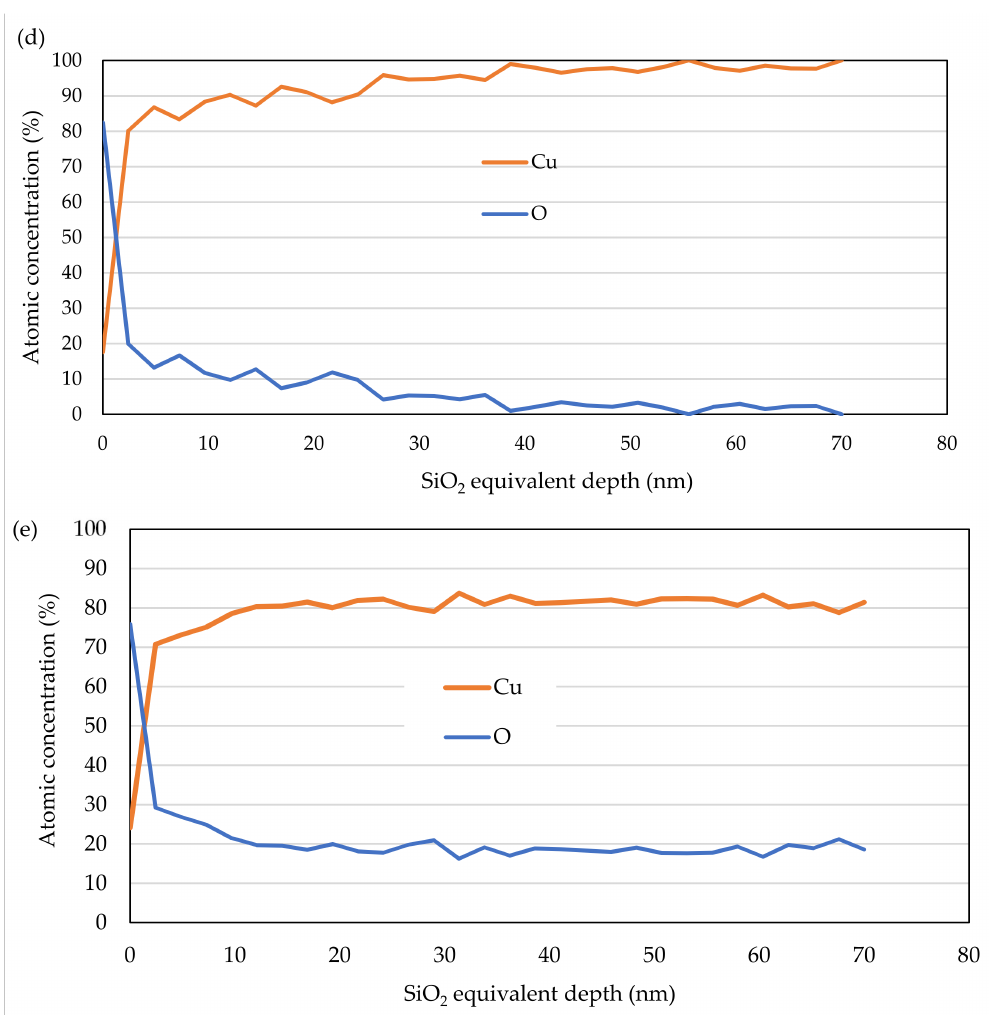
Figure 6. Depth profile analysis of C1020 ( a ) at RT, ( b ) annealed at 100 ◦ C, ( c ) annealed at 200 ◦ C, ( d ) annealed at 300 ◦ C, and ( e ) annealed at 400 ◦ C.